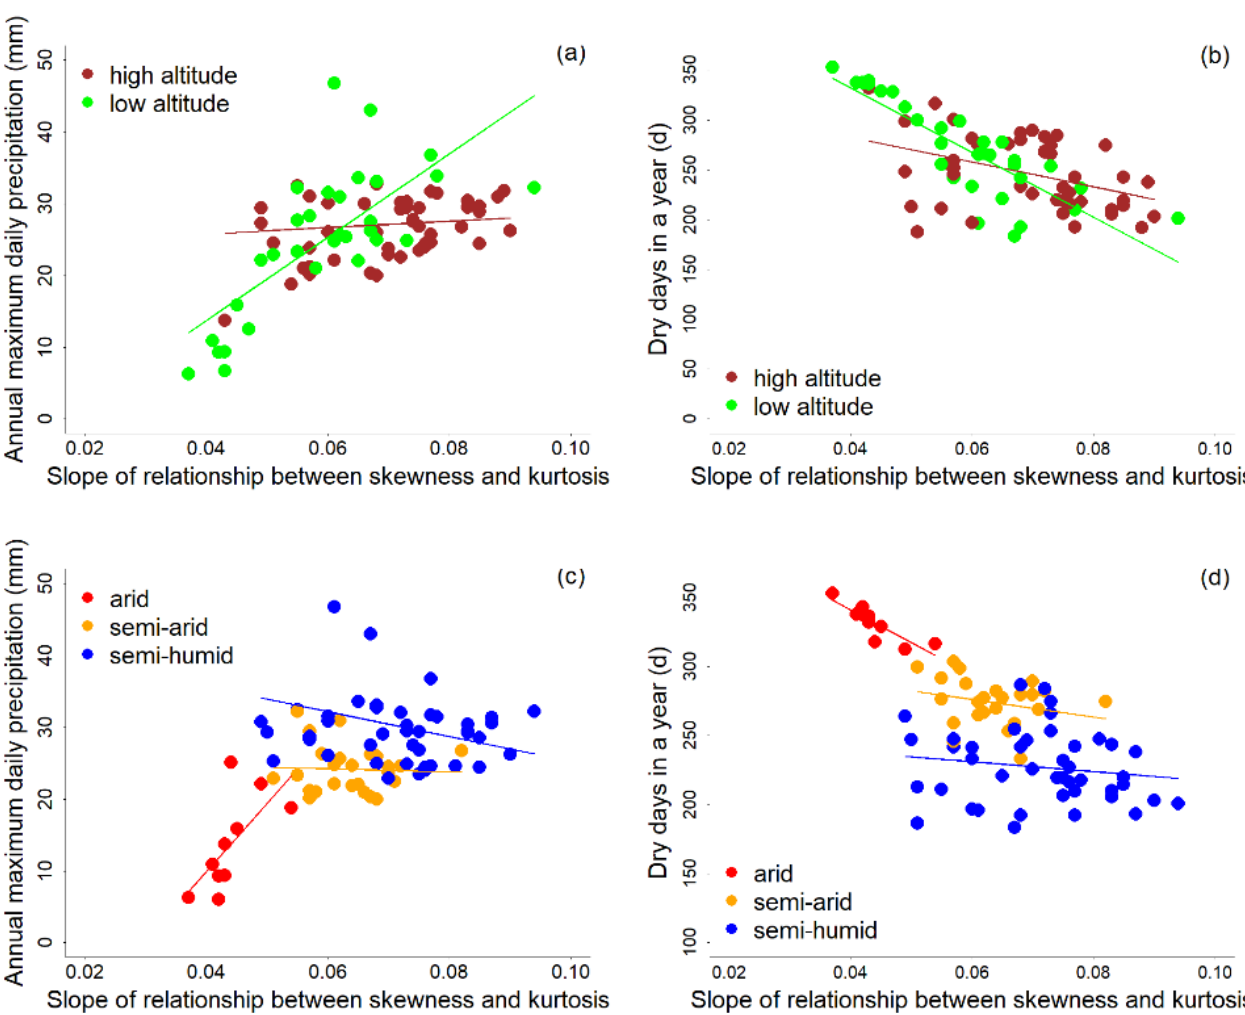
Figure 5. Effects of precipitation extremes on skewness–kurtosis interactions of annual precipitation distribution. Precipitation extremes were shown by two indices, namely annual maximum daily precipitation and the number of dry days in a year. The effects of both indices were assessed in terms of various altitudes ( a , b ) and climate zones ( c , d ).